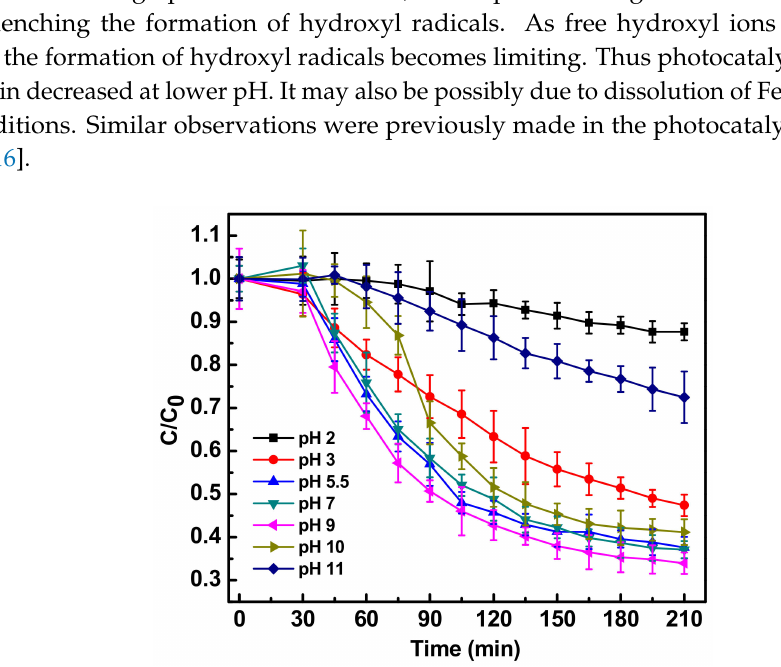
Figure 4. Photocatalytic degradation of antibiotic ciprofloxacin (10 mg/L) in water in the presence of Fe-ZnO nanoparticles (150 mg/L) irradiated with sunlight intensity of 80,000 ± 3000 lux at different reaction pH of 2, 3, 5.5, 7, 9, 10, 11. C 0 represents initial concentration of ciprofloxacin and C represents concentration of ciprofloxacin at a particular time point. C/C 0 denotes the time dependent change in ciprofloxacin concentration with respect to initial